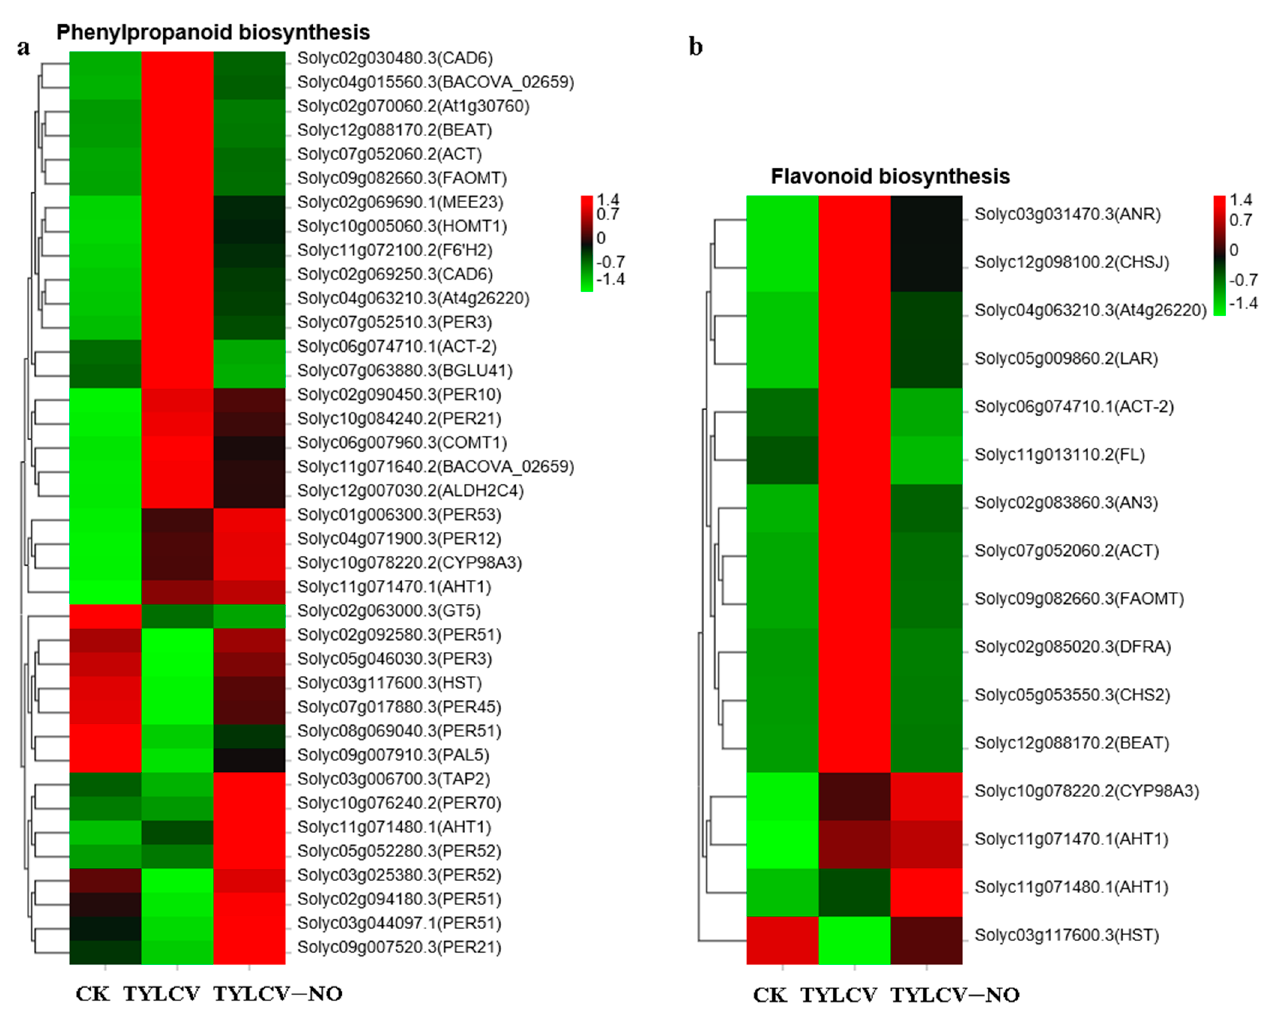
Figure 6. Expression of genes related to secondary metabolites biosynthesis in tomato, ( a , b ) are the gene expression of phenylpropanoid biosynthesis and flavonoid biosynthesis, respectively. Different colors indicate the expression level of each gene after normalization by